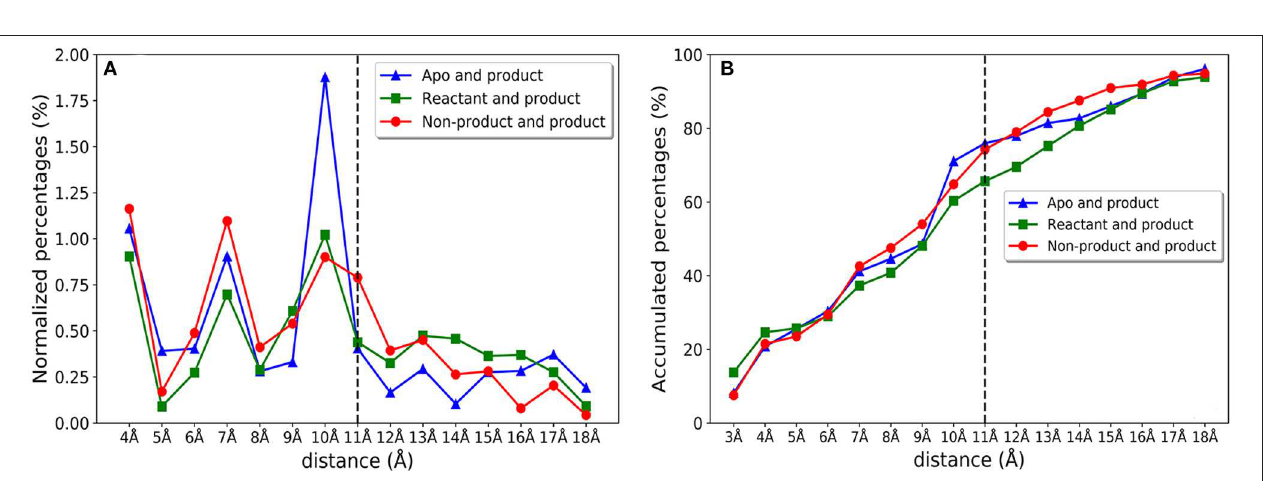
FIGURE 9 | Top 10 residues with the highest feature importance in TEM-1 β -lactamase based on classification models: (A) Apo/product model, (B) Reactant/product model, (C) Non-product/product model; The structures of top 10 residues with the highest feature importance and their positions comparing with the active site of TEM-1 in each model: (D) apo/product model, (E) reactant/product model, and (F) non-product/product model. The ligand penicillin-G molecule is also illustrated as green transparent surface. The active site of TEM-1 is the pocket holding the penicillin-G molecule.